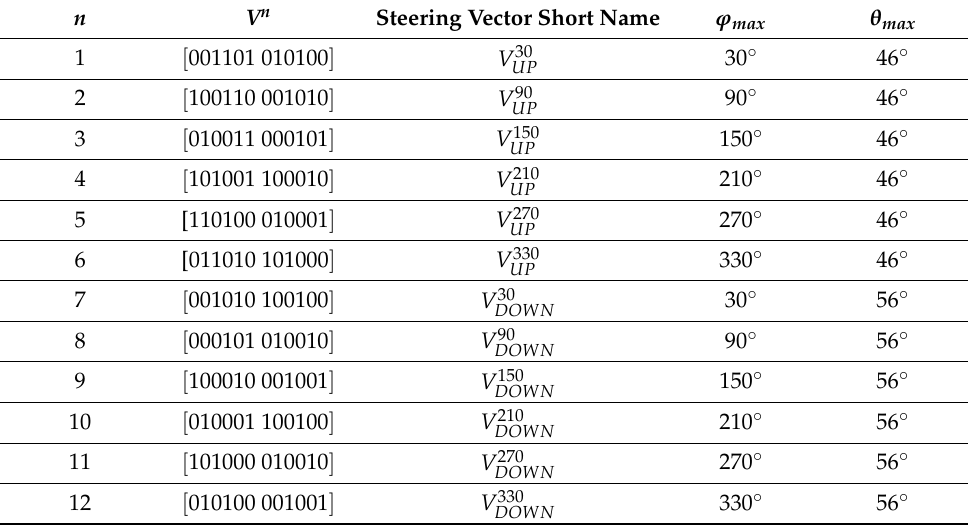
Table 2. Two-row ESPAR antenna steering vectors used in RSS-based DoA estimation. n V